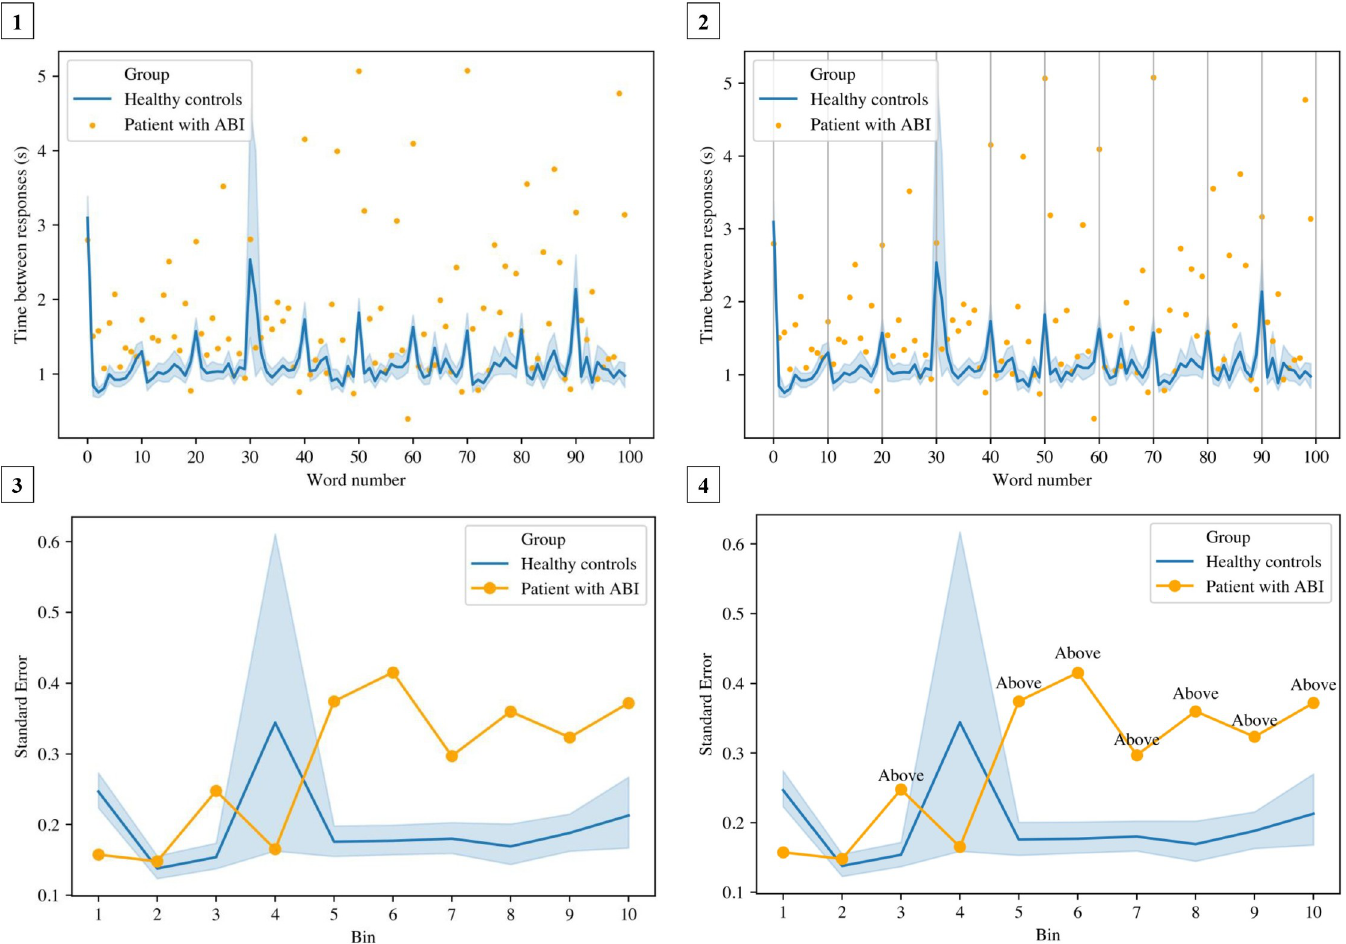
Fig 1. The development of the performance stability measures. The development (in this example the Stroop, condition 3) is illustrated for one patient in four steps: (1) The “time between responses” (in seconds) is depicted on the vertical axis, with the orange dots reflecting the time between responses for one patient. The words (100 words in total) are depicted on the horizontal axis. The blue line is the average time of the healthy controls ( n = 91) with a 95%CI (light blue shade); (2) In the Stroop, we computed 10 time bins of 10 words each. The standard error was calculated per time bin; (3) Here, the 10 time bins are depicted on the horizontal axis, and the standard error on the vertical axis. The orange line represents the standard error per time bin for one patient. (4) The number of time bins in which the standard error of a patient fell above normal range (e.g., 7 out of 10 bins) was computed into a proportion score (e.g., .7).